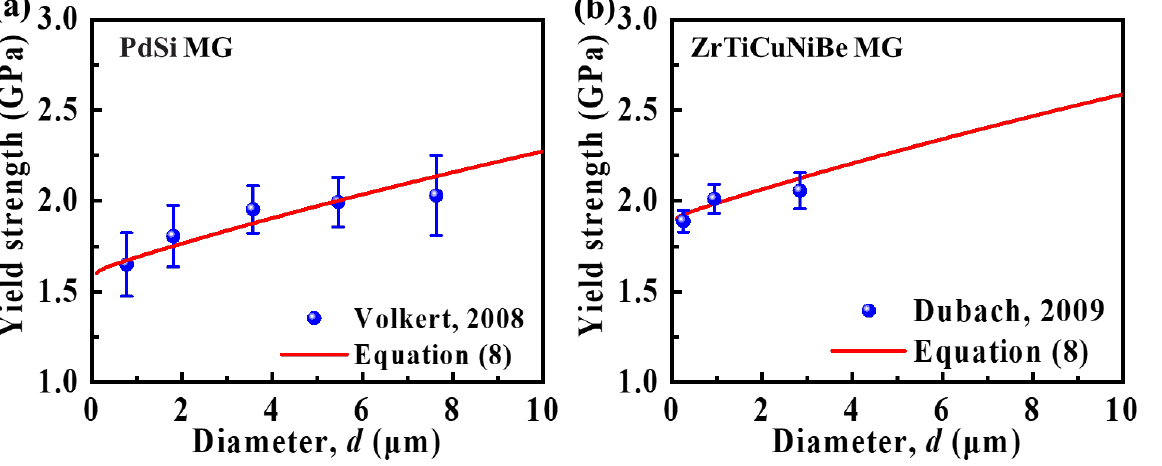
Figure 3. The yield strength as a function of micropillar diameter extracted from the experimental results of ( a ) Volkert et al. [26] and ( b ) Dubach et al. [27]. Our theoretical prediction is also plotted for comparison.